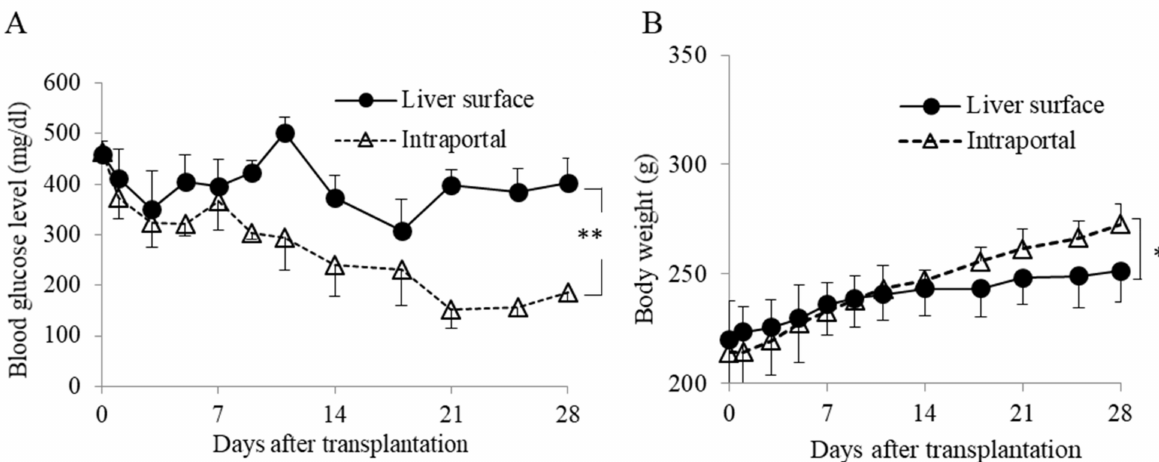
Figure 7. The outcome of islet (4 IEQs/g) engraftment after transplantation in the liver surface and intraportal groups. The changes in the blood glucose levels after islet transplantation ( A ) and the changes in body weight ( B ) after islet transplantation. The intraportal transplantation (intraportal group; white triangle, n = 4) showed significantly better blood glucose levels than liver surface transplantation with keratinocyte sheet (liver surface group; black circle, n = 4). Data are mean ± SEM (** p < 0.01, * p < 0.05,